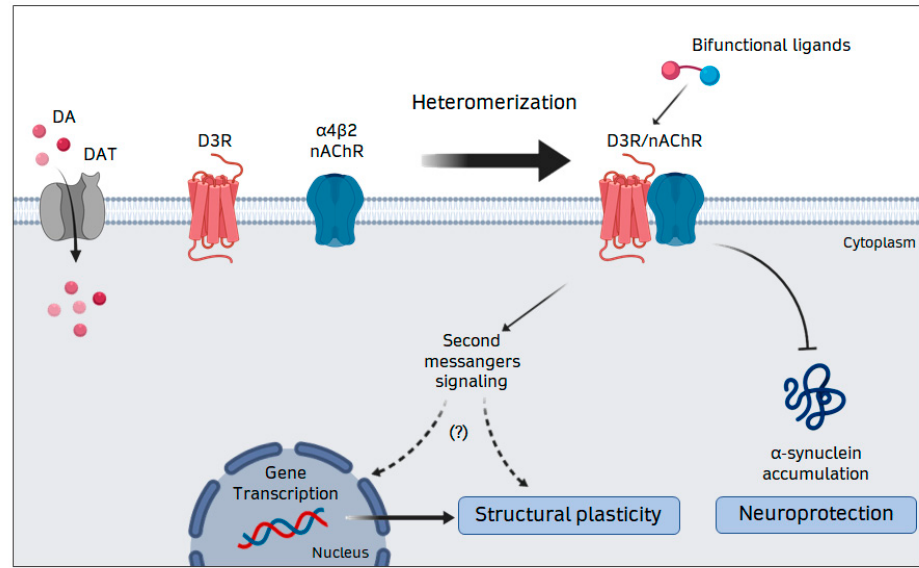
Figure 1. Representation of the heteromerization between the D3R and the α 4 β 2 nAChR in DA neurons. Abbreviations: DA, dopamine; DAT, dopamine transporter; D3R, dopamine D3 receptor; nAChR, nicotinic acetylcholine receptor.